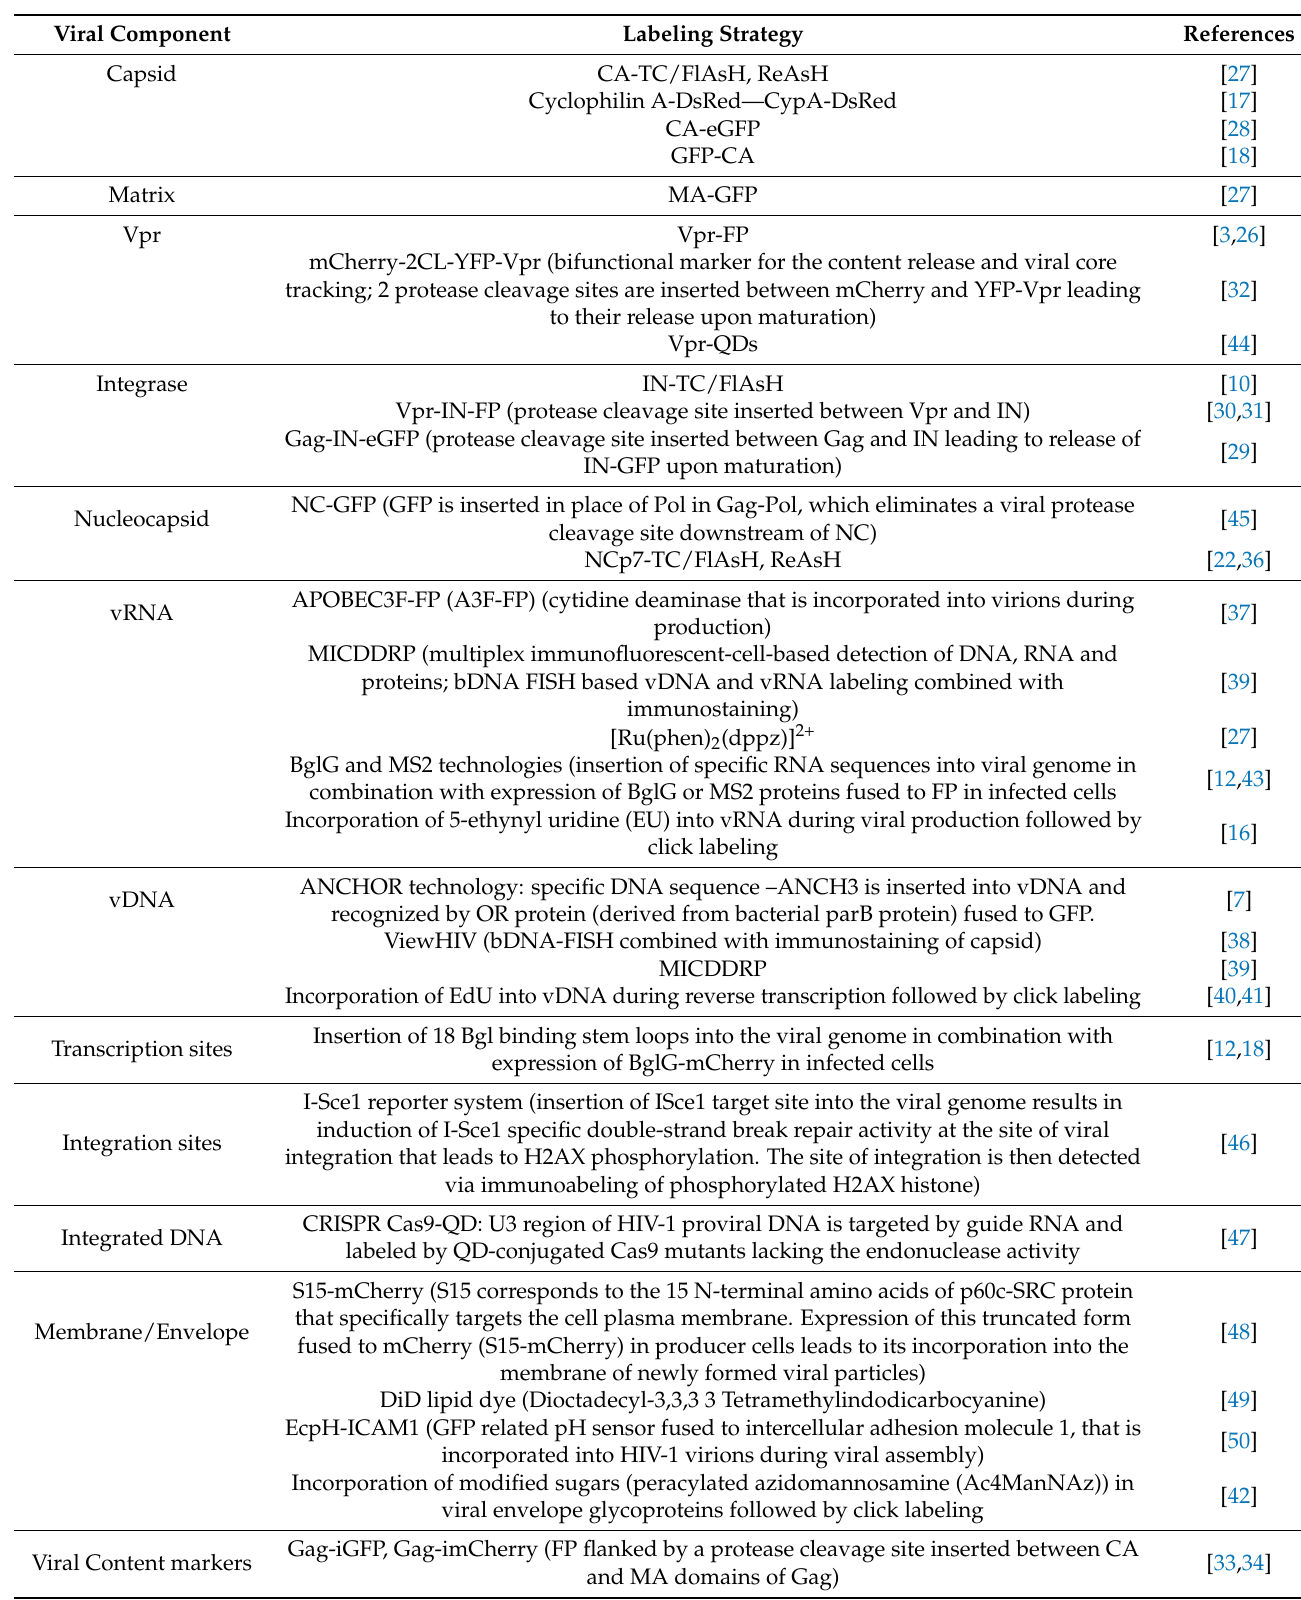
Table 1. Labeling strategies for HIV-1